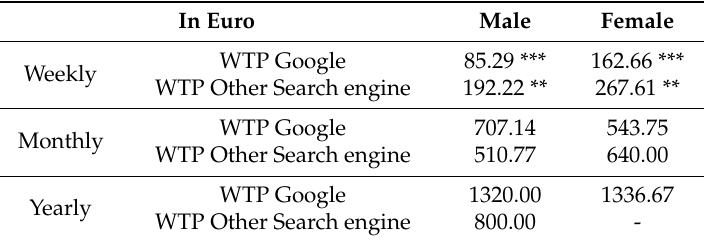
Table 1. Willingness-to-pay (WTP) for females and males.